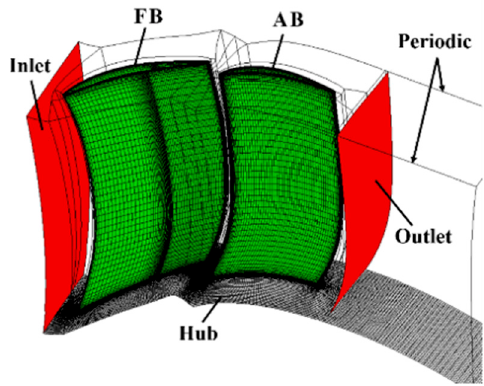
Figure 6. Compressor with tandem blades CFD mesh.